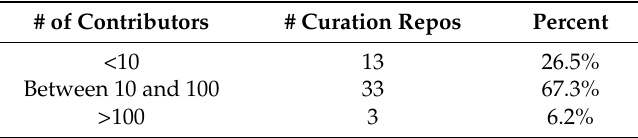
Table 6. The number of contributors to curation